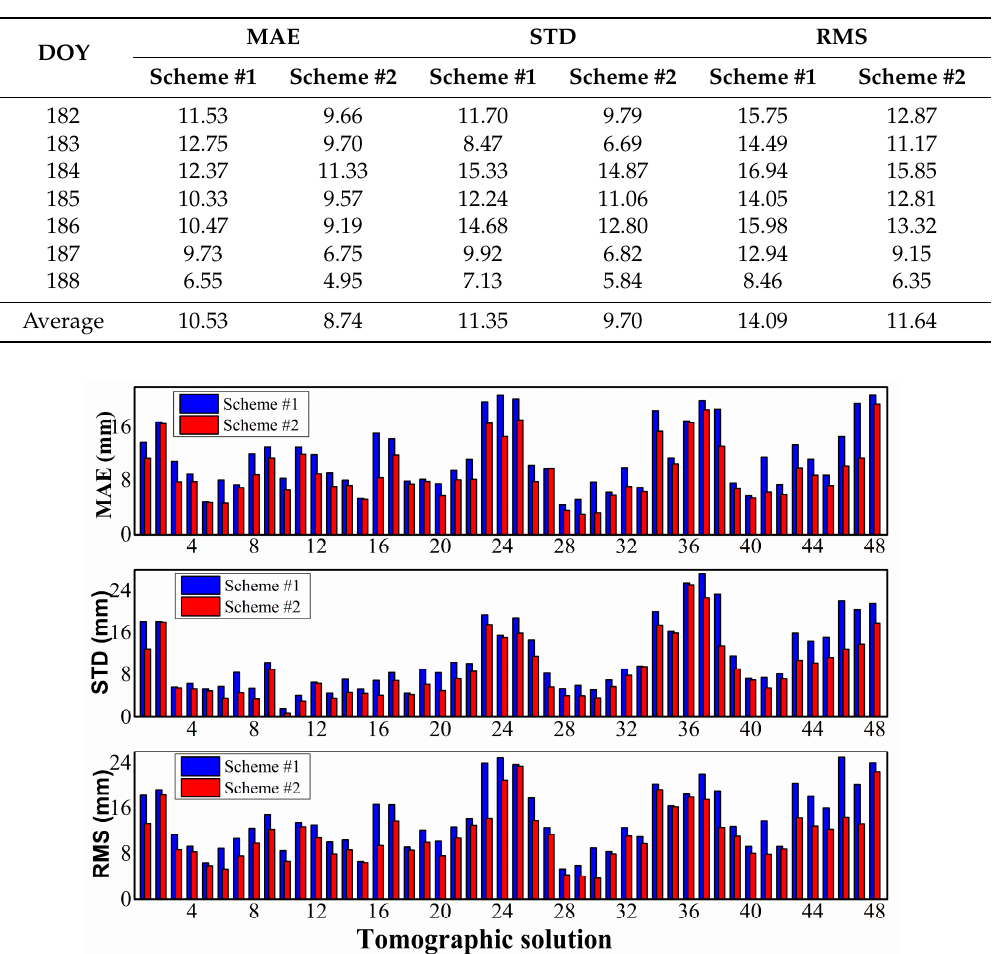
Figure 6. Accuracies in terms of MAE ( top ), STD ( middle ), and RMS ( bottom ) using two schemes in every tomographic solution of DOY 182, 2017.